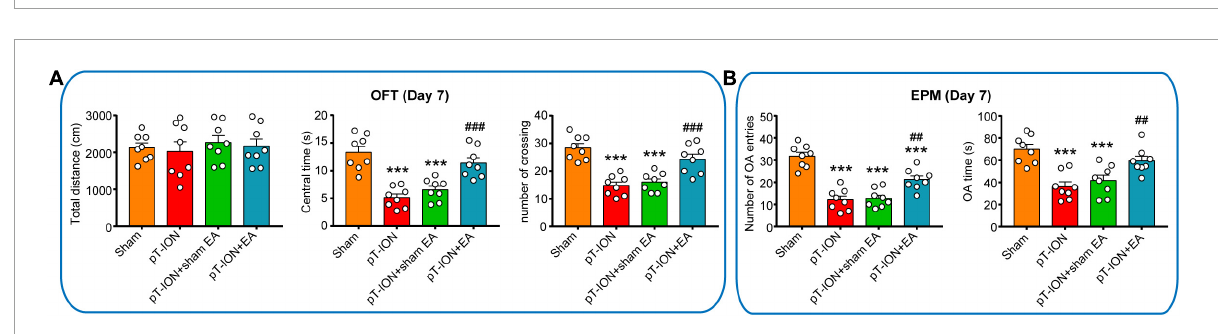
FIGURE4 Electroacupuncture (EA) attenuates pT-ION-induced anxiety-like behavior. On day 21 after pT-ION surgery (day 14 after EA every 2 days), no effect of EA on motor function is shown as the constant total distance (A) in the open-field test (OFT). The anxiolytic effects of EA are shown as an increased center time and number of crossing in the OFT (A) and increased number of OA entries and OA time (B) in the EPM test. N = 8 mice/group, *** P < 0.001 vs. sham group; ## P < 0.01, ### P < 0.001 vs. pT-ION group, one-way ANOVA and Tukey’s test.